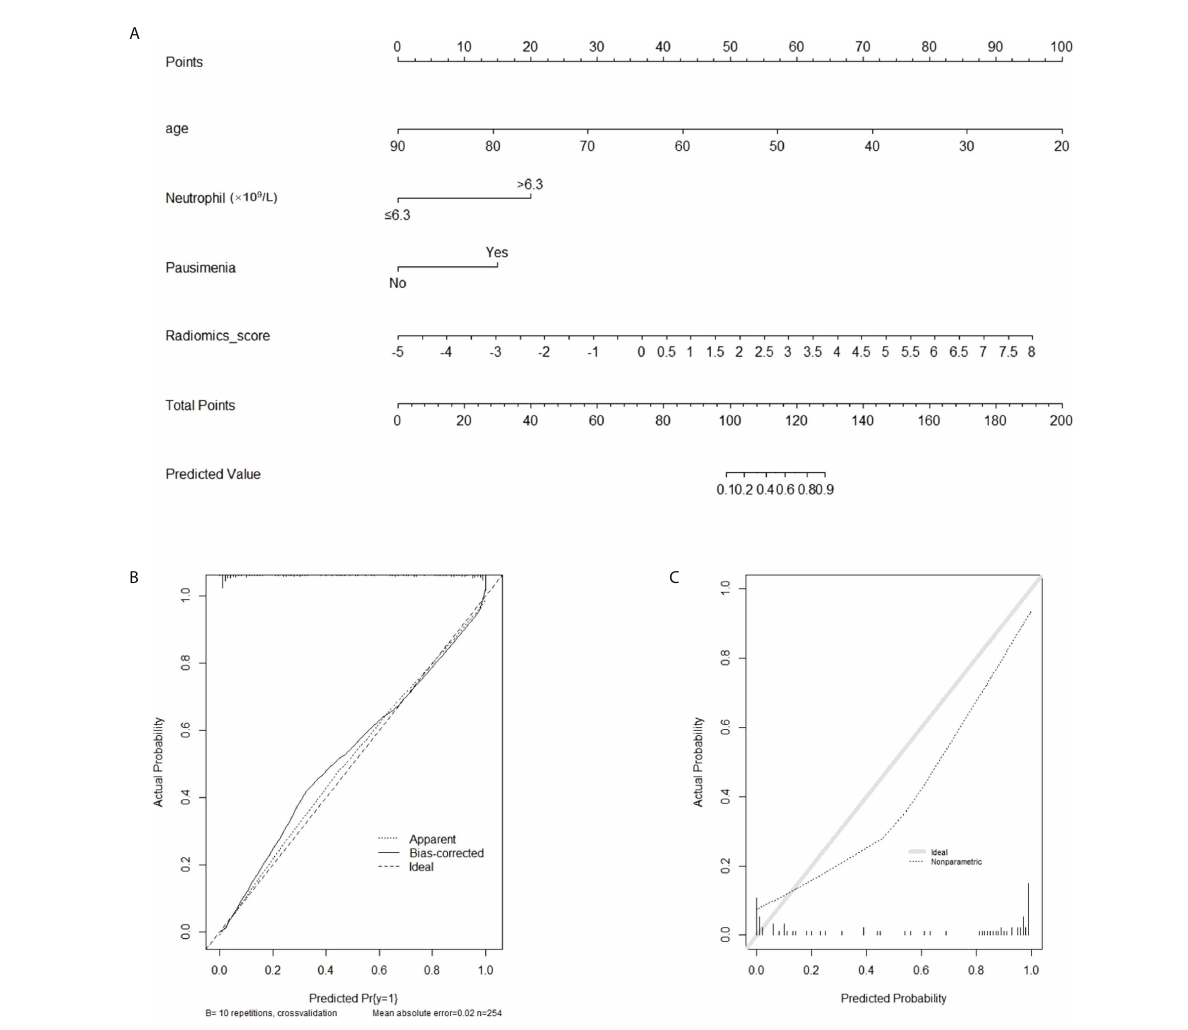
FIGURE 5 The radiomics-based nomogram for differentiating PDM/DE from IDC. (A) The radiomics-based nomogram developed with the training cohort included patient ’ s age and radiomics signatures. (B, C) Calibration curves of the radiomics-based classi fi cation model in the training (B) and validation (C)